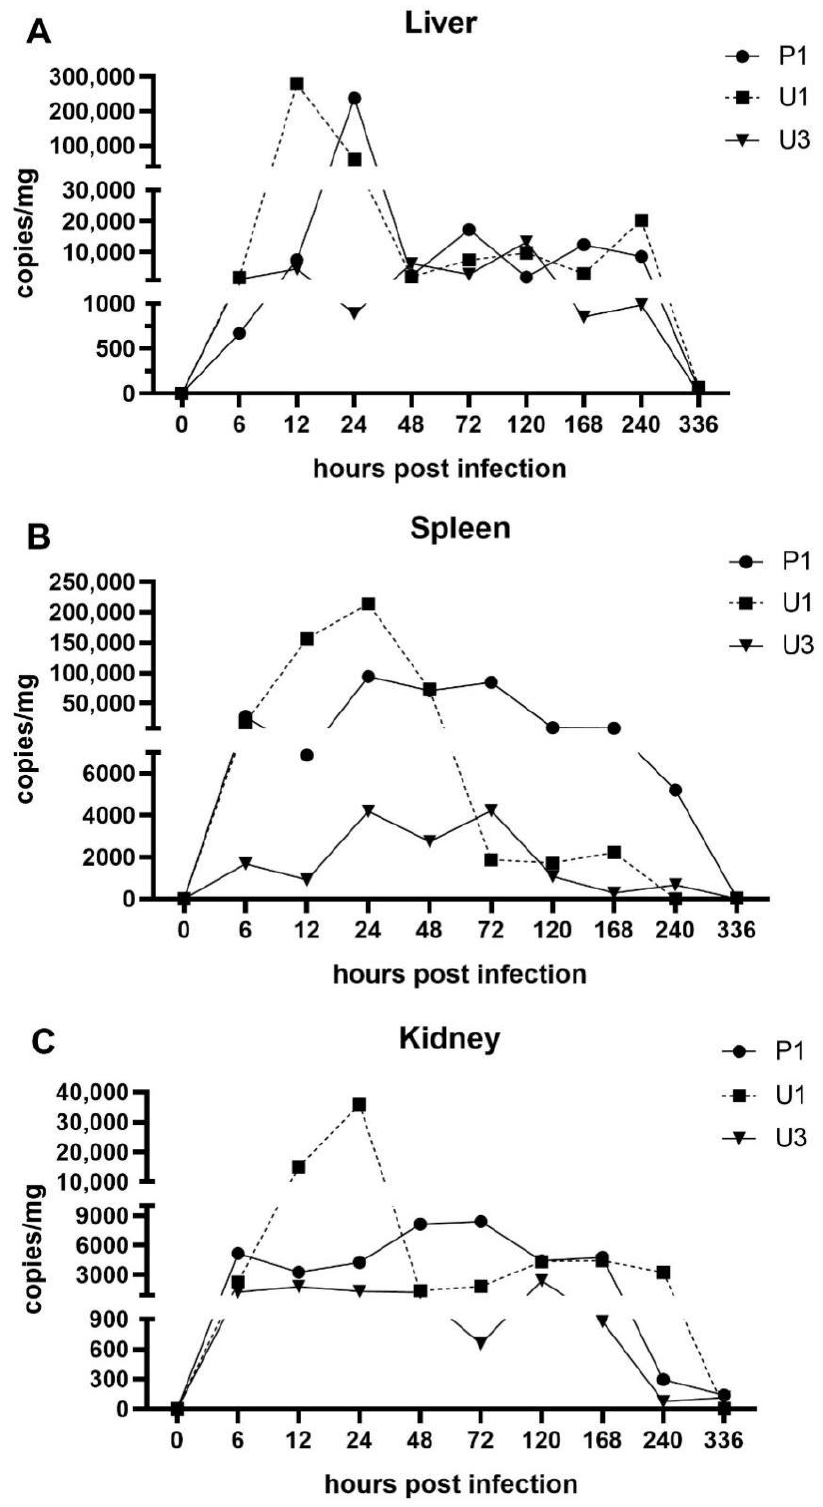
Figure 1. Viral loads in liver ( A ), spleen ( B ), and kidney ( C ) of largemouth bass in the P1, U1, and U3 groups infected with MSRV.